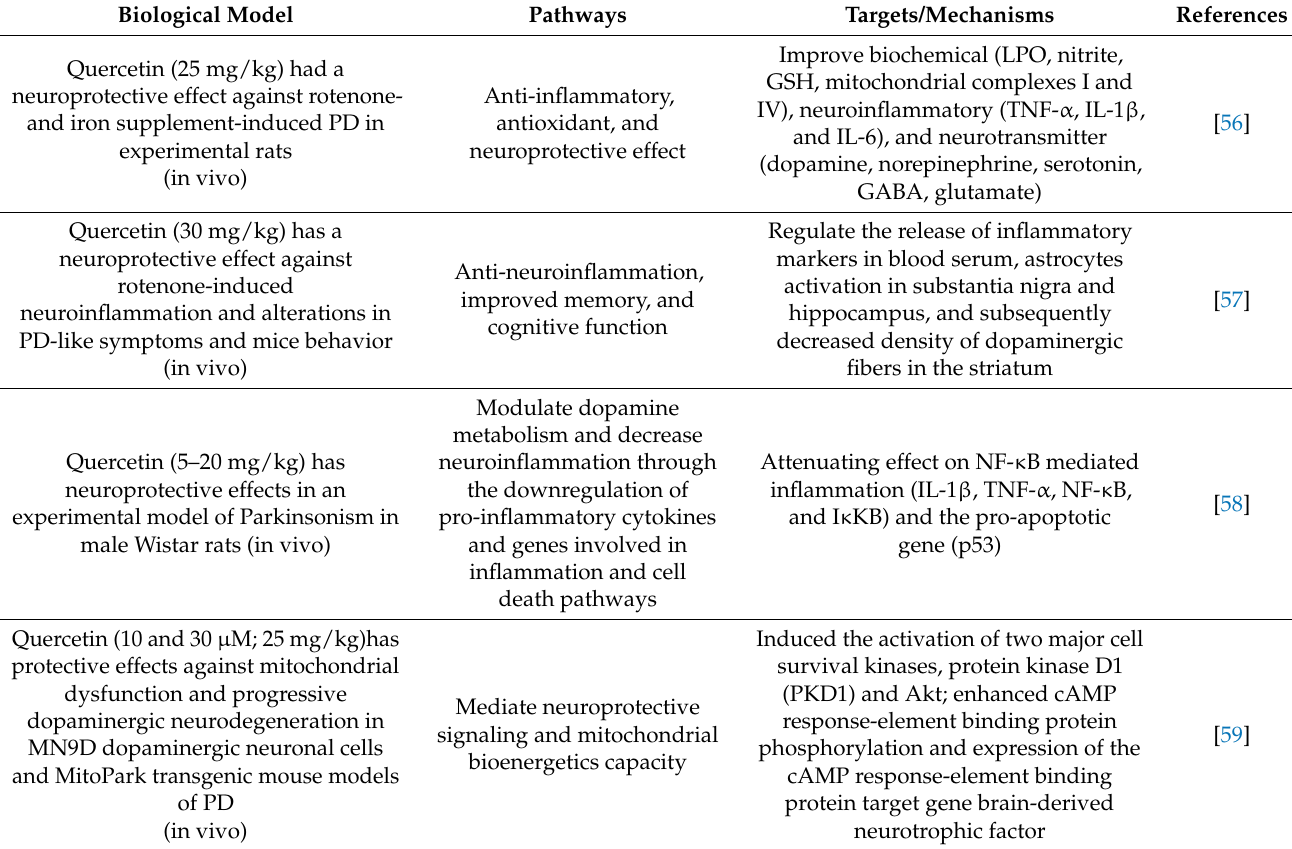
Table 2. Quercetin has neuroprotective and anti-inflammatory effects, reducing the production of pro-inflammatory cytokines in